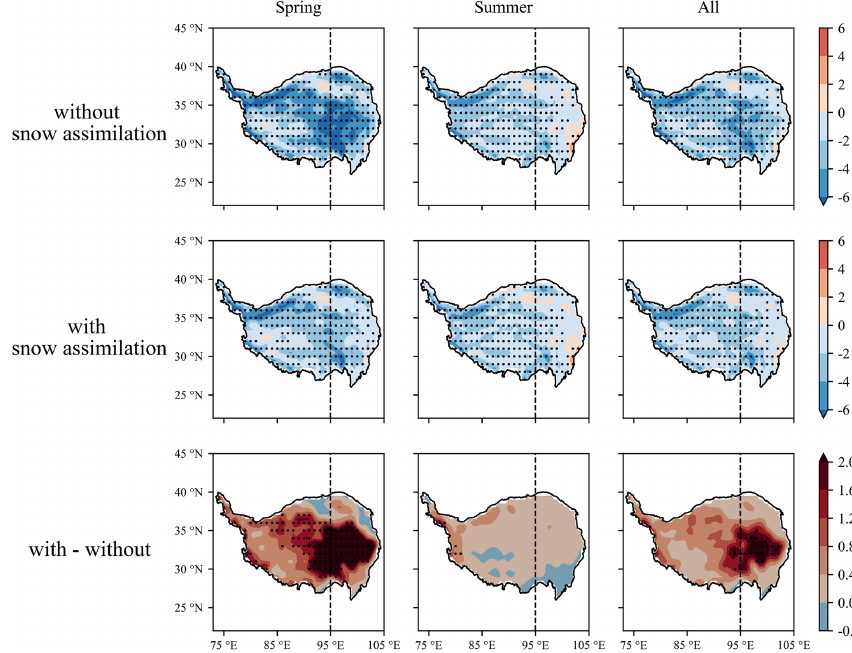
Figure 8. The spatial differences in daily temperature ( ◦ C) between the ensemble reforecasts and CN05.1 data (top and middle rows) and between the two reforecasts (bottom row). The stippled regions show the statistical significance of the differences identified by the t test at a 5% significance level.